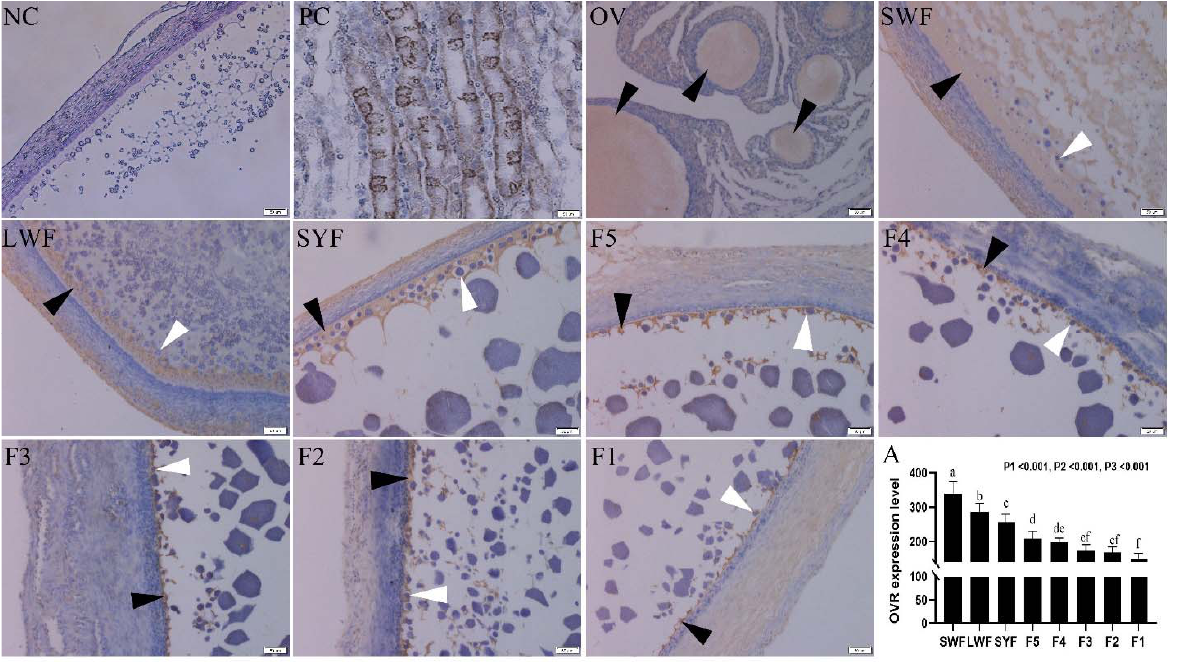
Figure 2. Immunohistochemical staining of oocyte vitellogenesis receptor (OVR) in different levels of follicles of Wanxi White goose. The black arrows indicated the OVR layer and the white arrows indicated the OVR endocytosis of vitelline. NC: negative control; PC: positive control; OV: part of ovary with follicles full of OVR; SWF: Small white follicles; LWF: Large white follicles; SYF: small yellow follicles; F5: F5 follicle; F4: F4 follicle; F3: F3 follicle; F2: F2 follicle; F1: F1 follicle; A: the quantification of OVR in the same area in each level of follicle. Scale bar is 50 µ m. a–f: different letter means significant difference among follicle levels ( p < 0.05).